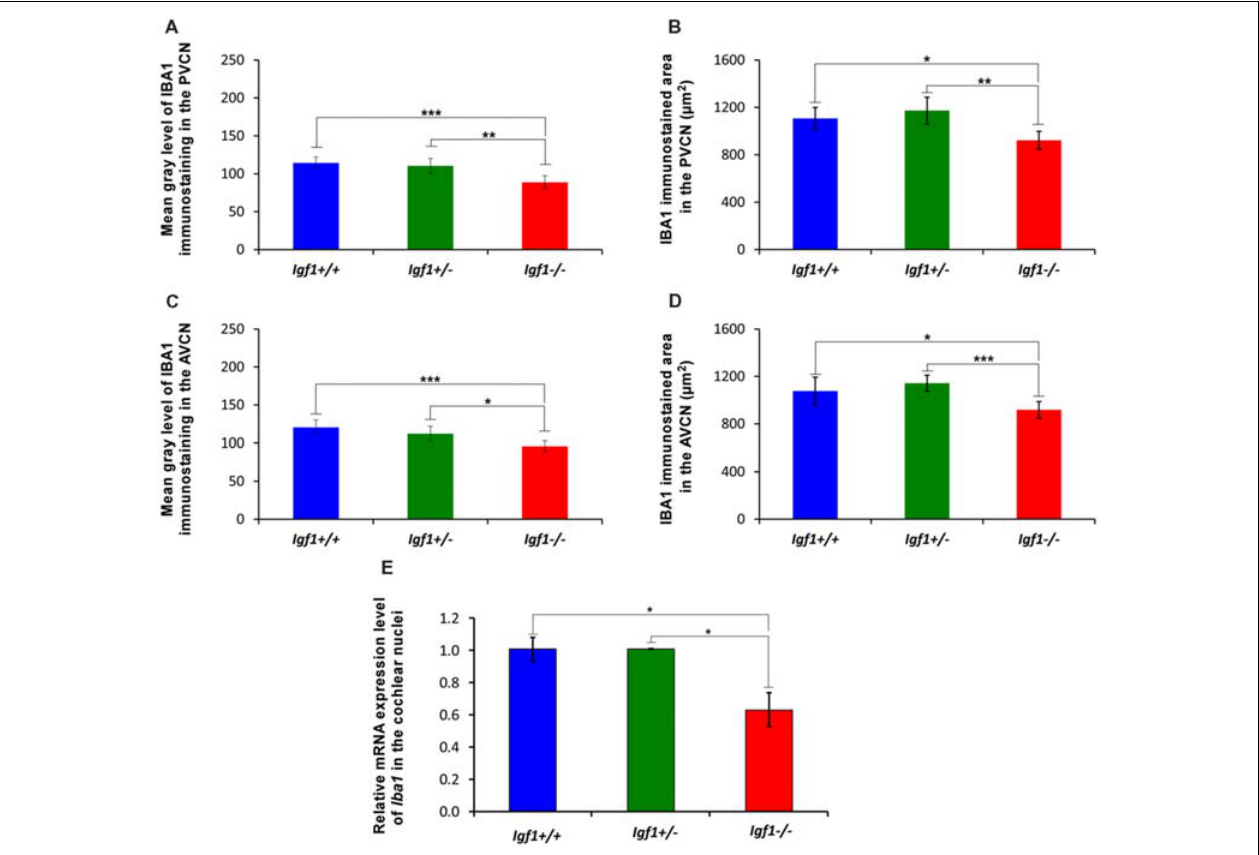
FIGURE 4 | Insulin-like growth factor 1 (IGF-1) deficiency leads to Iba1 downregulation in Igf1 − / − mice. Bar graphs showing decreases in the mean gray levels (A,B ) and immunostained areas (C,D) in the Igf1 − / − mouse cochlear nuclei when compared to Igf1 + / + and Igf1 + / − mice. Similar reductions in Iba1 expression were also detected by RT-quantitative PCR (qPCR; E ). Error bars indicate the standard deviations of the mean. Statistically significant differences among the animal groups were evaluated by one-factor ANOVA ( ∗ p < 0.05; ∗∗ p < 0.01, ∗∗∗ p < 0.001). Abbreviations: AVCN, anteroventral cochlear nucleus; PVCN, posteroventral cochlear